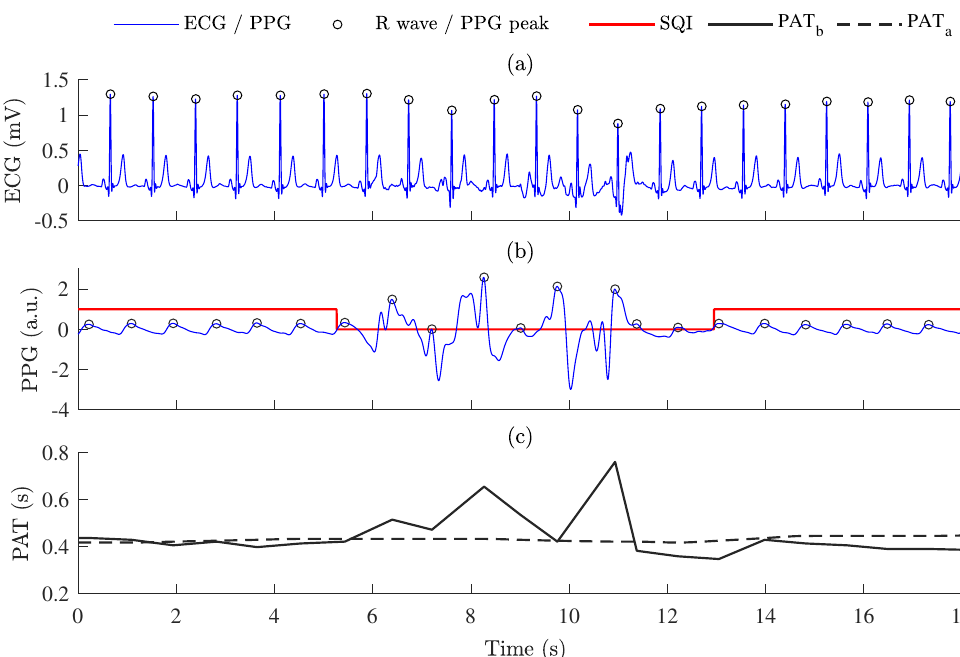
Figure 5. The relationship between PPG signal quality and PAT: ( a ) ECG signal; ( b ) PPG signal with labeled signal quality (SQI); ( c ) PAT variations estimated as time intervals between ECG R peaks and PPG systolic peaks—PAT before post-processing, PAT b , and PAT after post-processing, PAT a